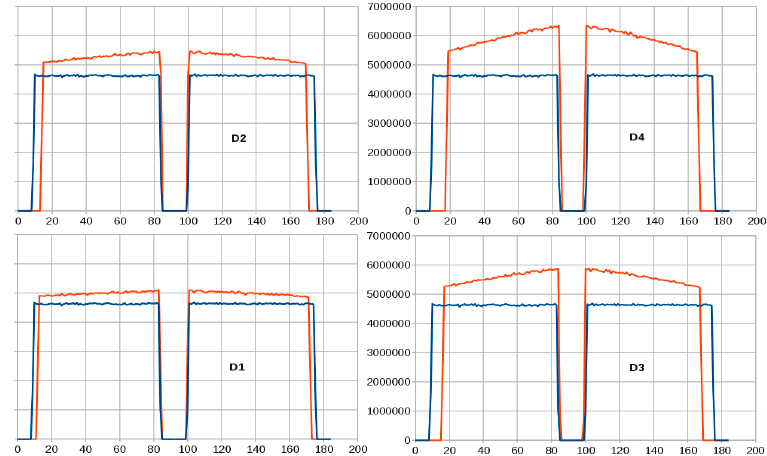
Figure 14. Computer simulations showing radiation profiles collected at detectors D1, D2 (before P1 hole), D3 and D4 (after P1 hole). In blue for the correct geometry; in red for P2 at z = 99.0 mm, so the distance between P1 and P2 is 1 mm longer. The vertical axis represents the simulated radiation flux (resulting from 10 9 input rays). The horizontal axis represents the horizontal radial distance (with the central hole in the middle).